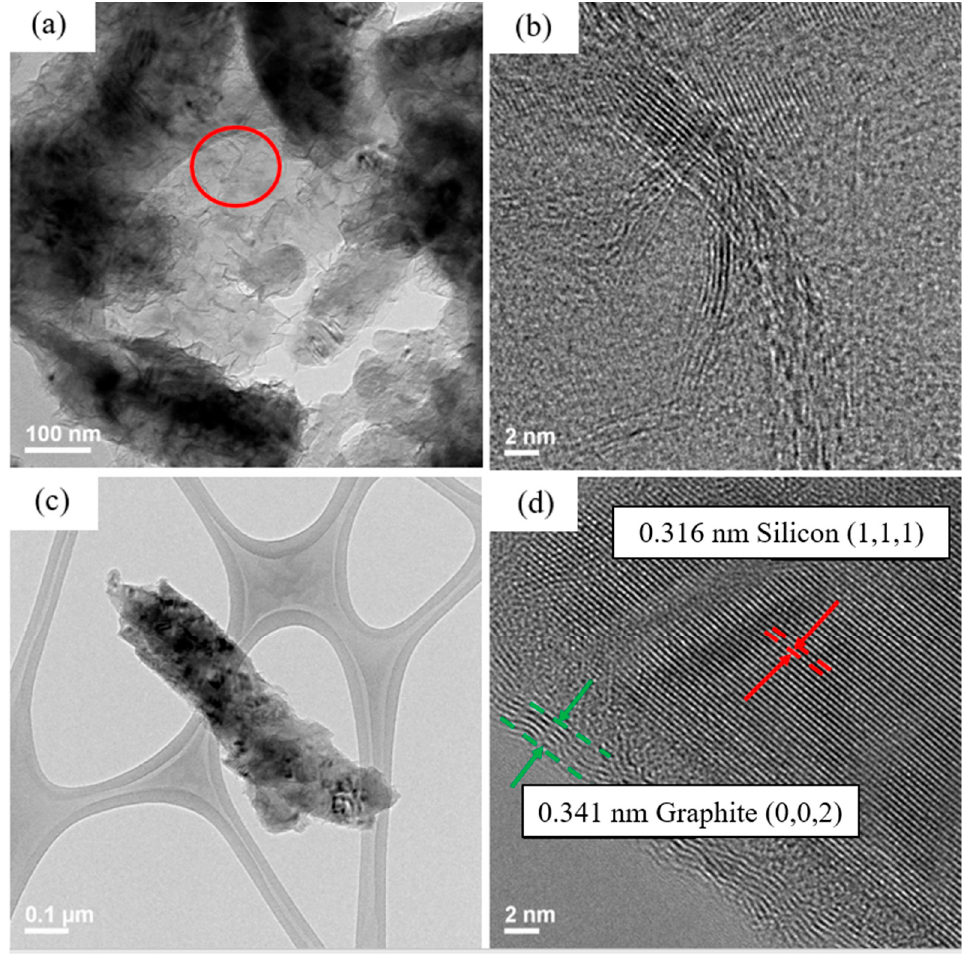
Figure 5. TEM images of ( a ) pyrolytic silicon anode, ( b ) pyrolytic binder, and ( c , d ) silicon flakes after pyrolysis.